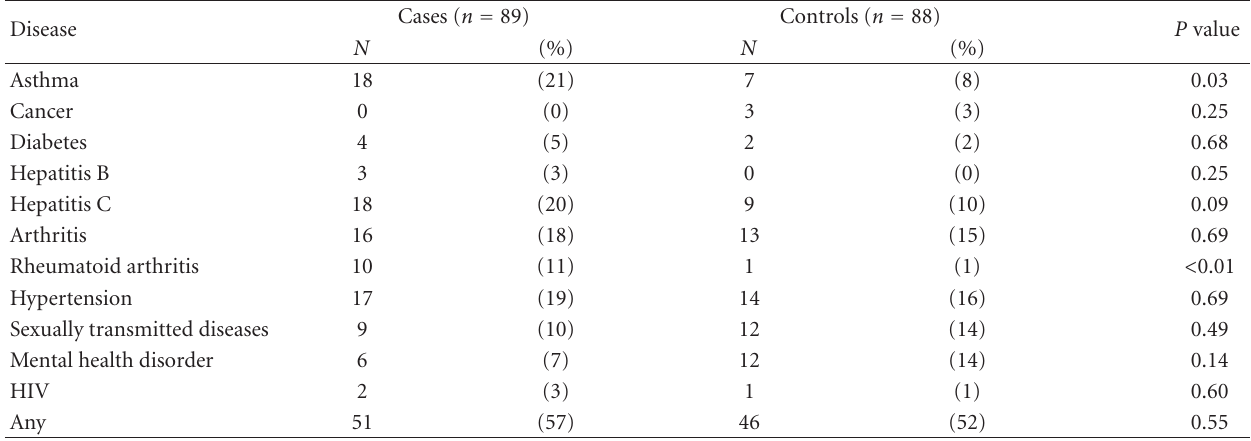
Table 4: Baseline medical history of LTBI cases and controls.